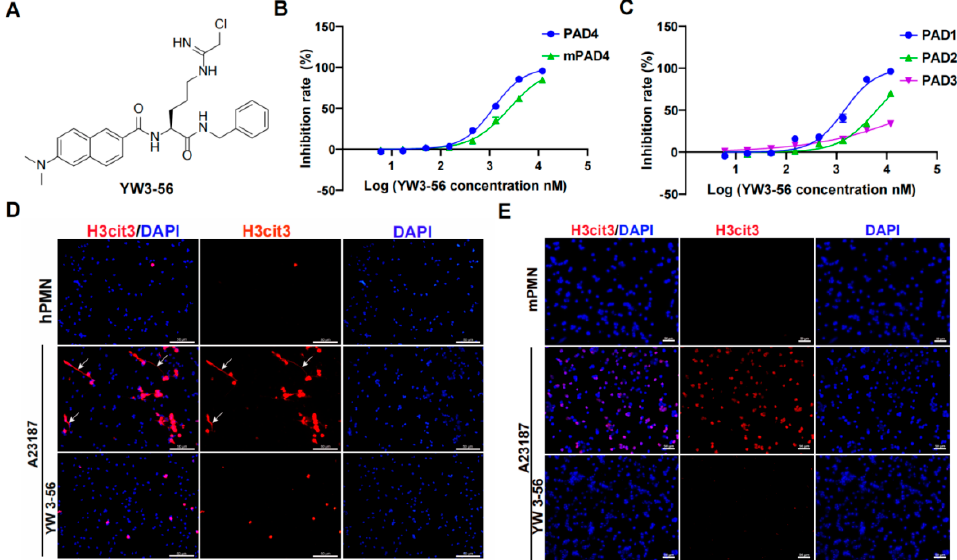
Figure 1. PAD inhibitor YW3-56 inhibits histone citrullination and NET formation. ( A ) YW3-56 is designed based on a structural similarity with the substrate of PAD family peptidylarginine. ( B ) YW3-56 inhibits mouse PAD4 and human PAD4 activity with IC50 of 2.54 × 10 3 nM and 1.19 × 10 3 nM. ( C ) YW3-56 inhibits PAD1, 2, and 3 with IC50 of 1.45 × 10 3 nM, 6.34 × 10 3 nM, and 53.43 × 10 3 nM. ( D ) Upon calcium ionophore treatment, human peripheral blood neutrophils increased histone citrullination (red) and NET formation (white arrow) detected by immunostaining with a histone H3Cit (Cit2, 8, 17) antibody. DNA dye DAPI staining in blue. NET formation and histone citrullination were decreased upon YW3-56 treatment. ( E ) Mouse bone marrow neutrophils showed a dramatic increase of histone citrullination after calcium ionophore treatment. YW3-56 treatment blocked the increase of histone citrullination. Scale bars represent 50 μ m. hPMN, human polymorphonuclear cell; mPMN, mouse polymorphonuclear cell; PAD, peptidylarginine deiminase. NET, neutrophil extracellular trap.